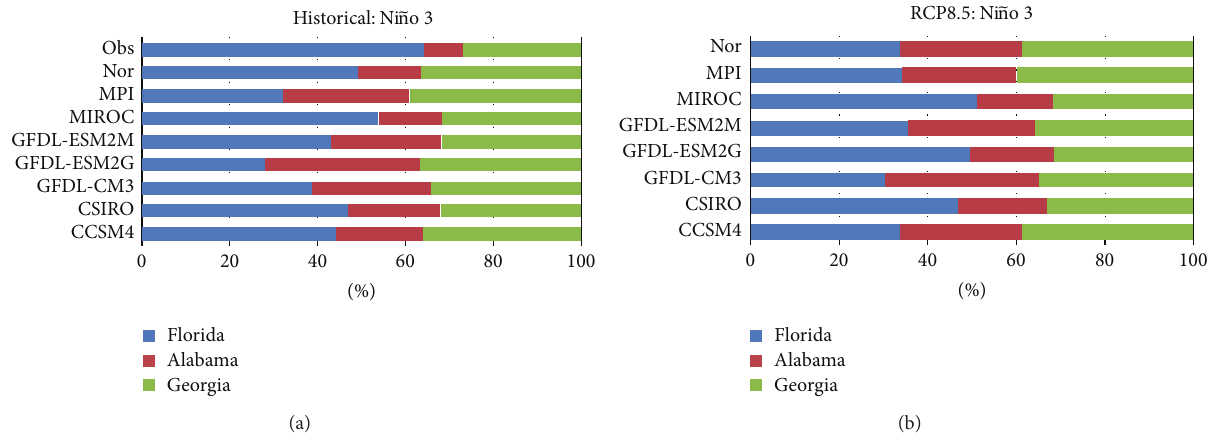
over the Ni ˜ no 3 region accounts for 49% of the variance of winter precipitation over the region. The explained